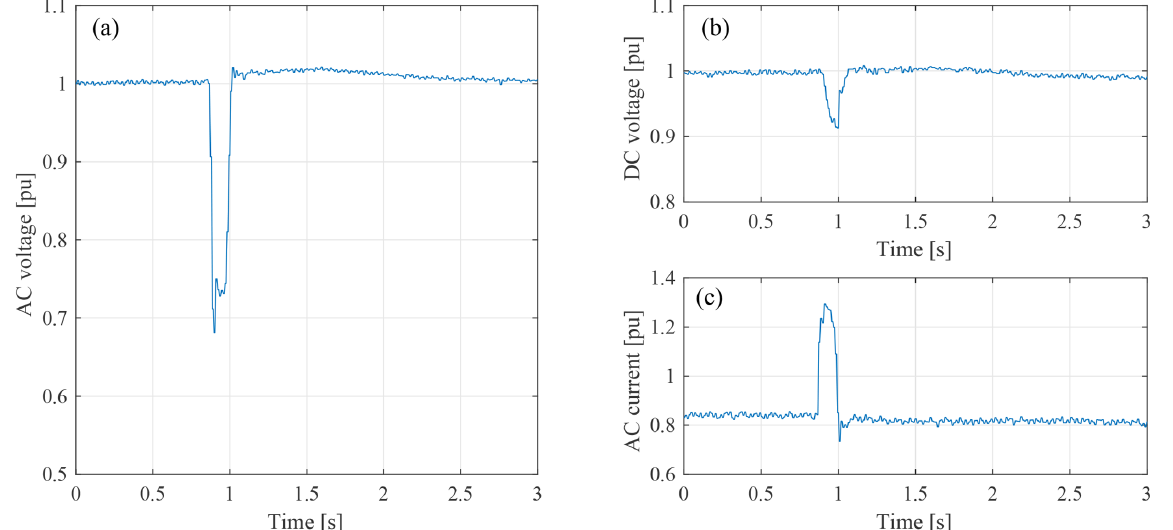
Figure 9. Wind turbine VSC under a voltage dip: AC voltage resulting at the LV side of the wind turbine transformer (a) , and DC voltage (b) and AC current magnitude measured at the grid-side VSC (c) .